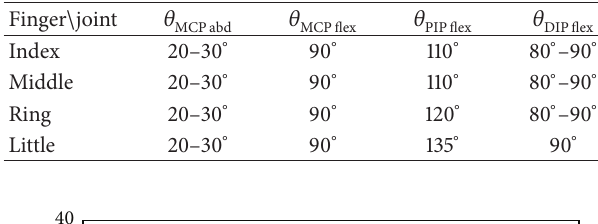
Table 1: D-H parameters of kinematic chains corresponding to the index to little fingers, considering metacarpal links fixed.